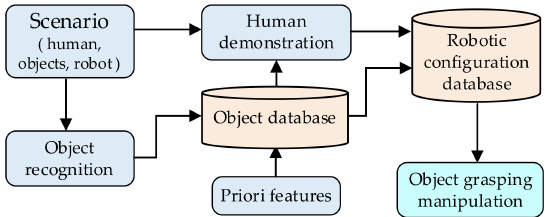
Figure 9. Functional flowchart of object grasping by learning from demonstration